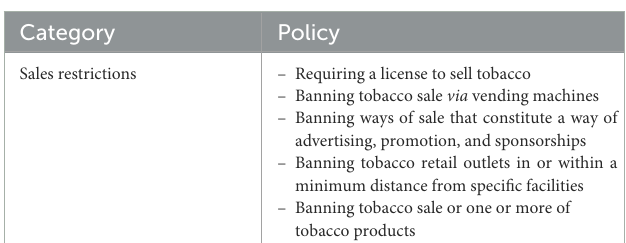
TABLE 3 Policies identified from the CTFK